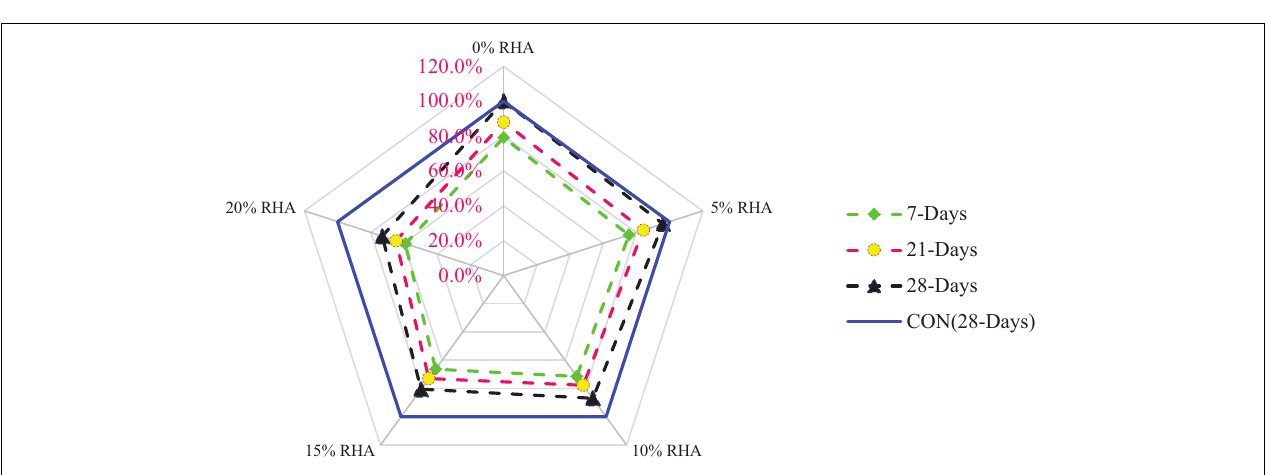
FIGURE 6 | Split tensile strength (without steel fibers and superplasticizer).